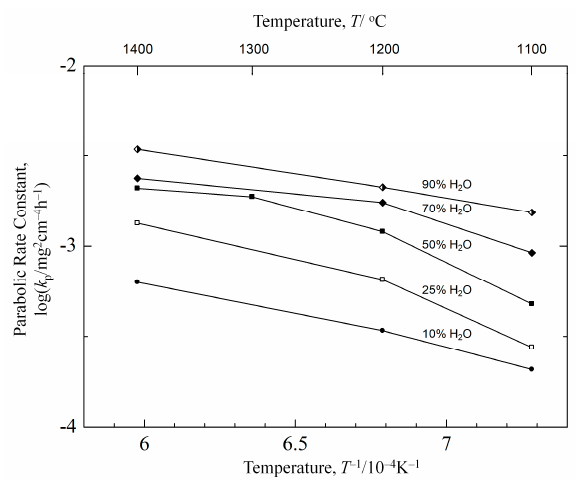
Figure 7. Influence of steam partial pressure on parabolic oxidation rate constant reported by Opila [45]. Impurities from environment can also affect the oxidation of SiC in steam at high temperatures. Opila [51] investigated the oxidation kinetics of CVD-SiC at 1200–1400 ° C in 10 vol% H 2 O/O 2 mixture using TGA with either pure Al 2 O 3 or fused quartz reaction tubes. Results of the investigation (Figure 8) indicated that the parabolic oxidation rate of SiC samples tested in Al 2 O 3 reaction tube was about one order of magnitude higher than that of SiC samples tested in quartz tube. It was found that the steam oxidation of SiC in Al 2 O 3 reaction tube led to sodium and aluminum contamination of the oxide scale. The sodium and aluminum might be transported from the Al 2 O 3 reaction tube to the SiC sam- ple surface in the gas phase to form less protective oxide scales.